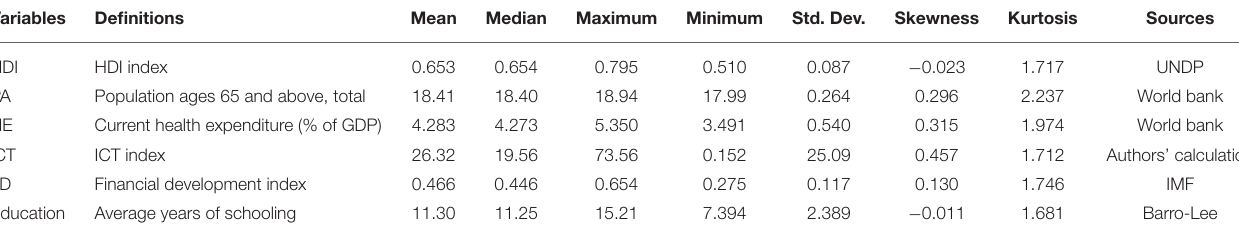
TABLE 1 | Variables and data description.